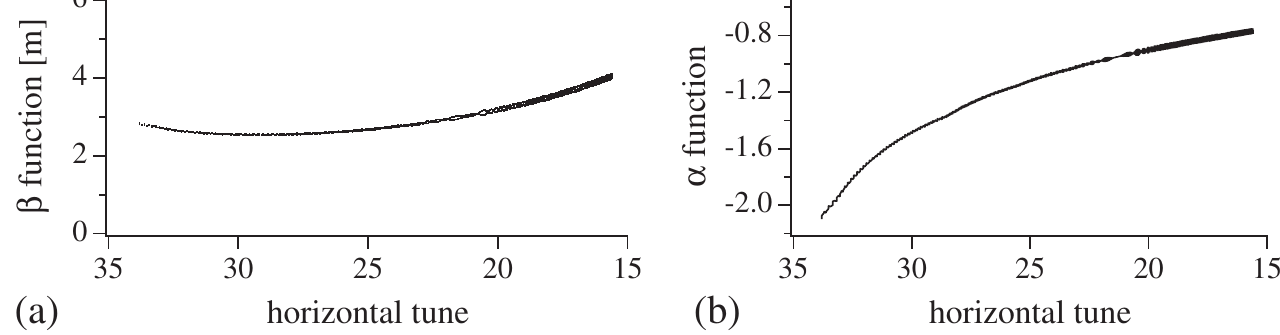
FIG. 7. Evolution of lattice functions (a) (cid:2) and (b) (cid:6) in an error-free